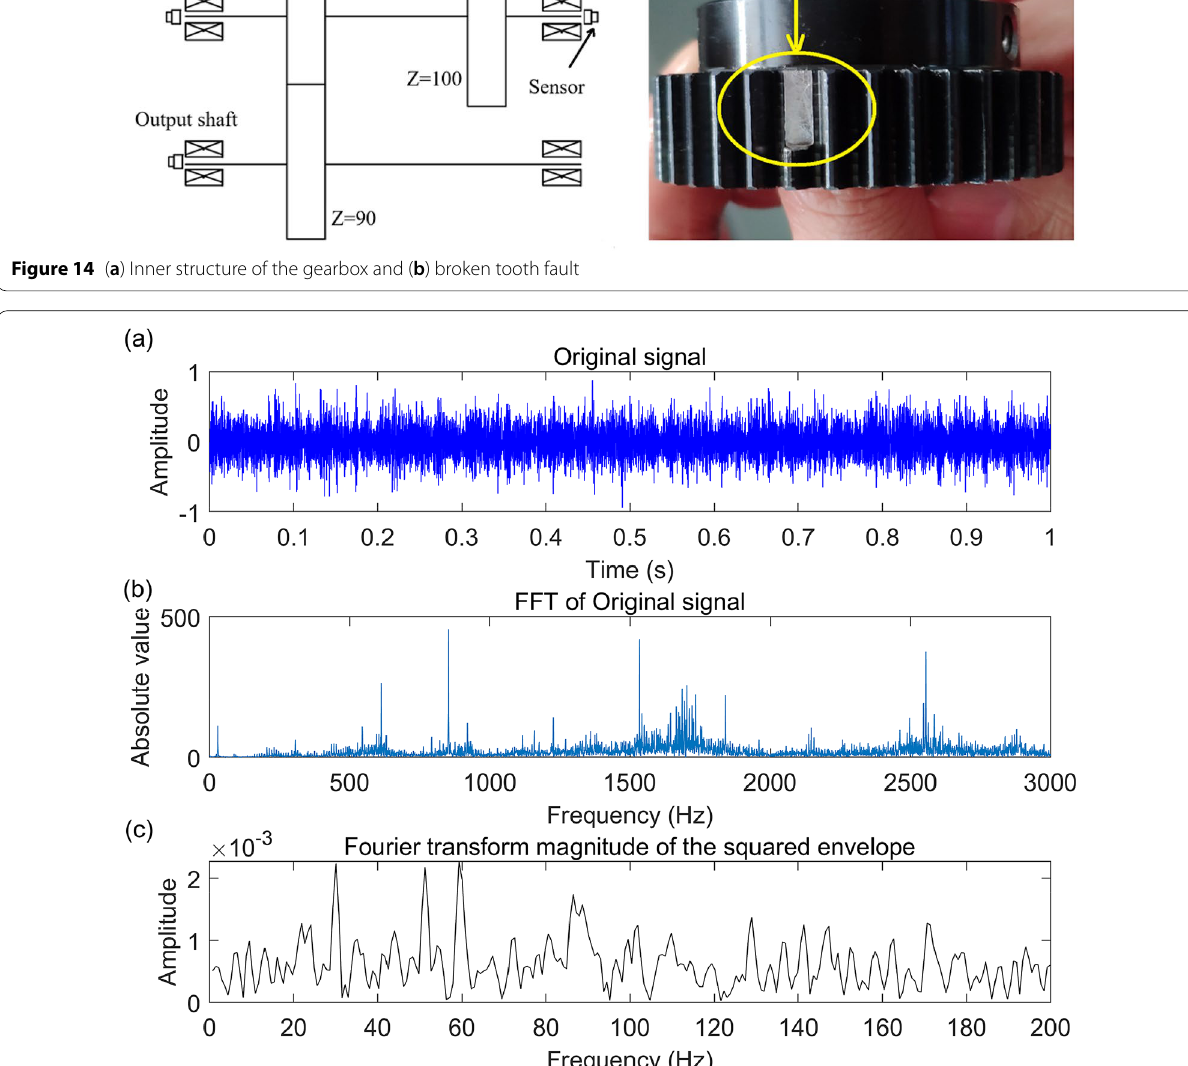
Figure 15 ( a ) Time waveform of the root crack fault signal, ( b ) frequency spectrum of the root crack fault signal, and ( c ) squared envelope spectrum of the broken tooth fault